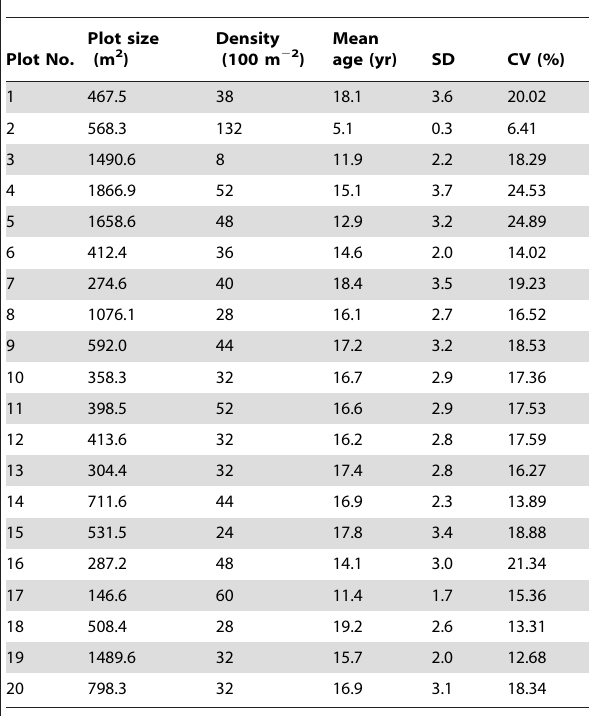
Table 4. Age structure of P. euphratica at the sites investigated in the fourth observation.